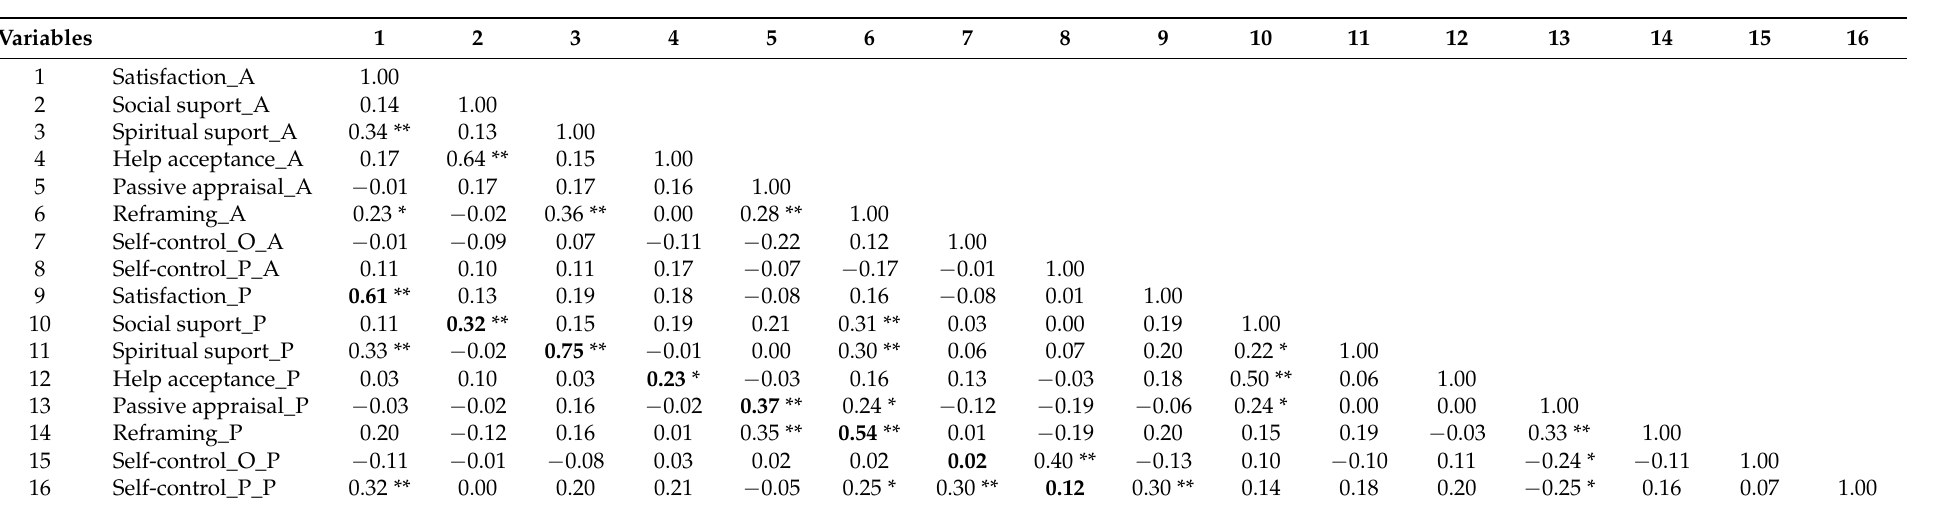
Table 2. Pearson’s correlations between perceived partner’s self-control, coping strategies, and relationship